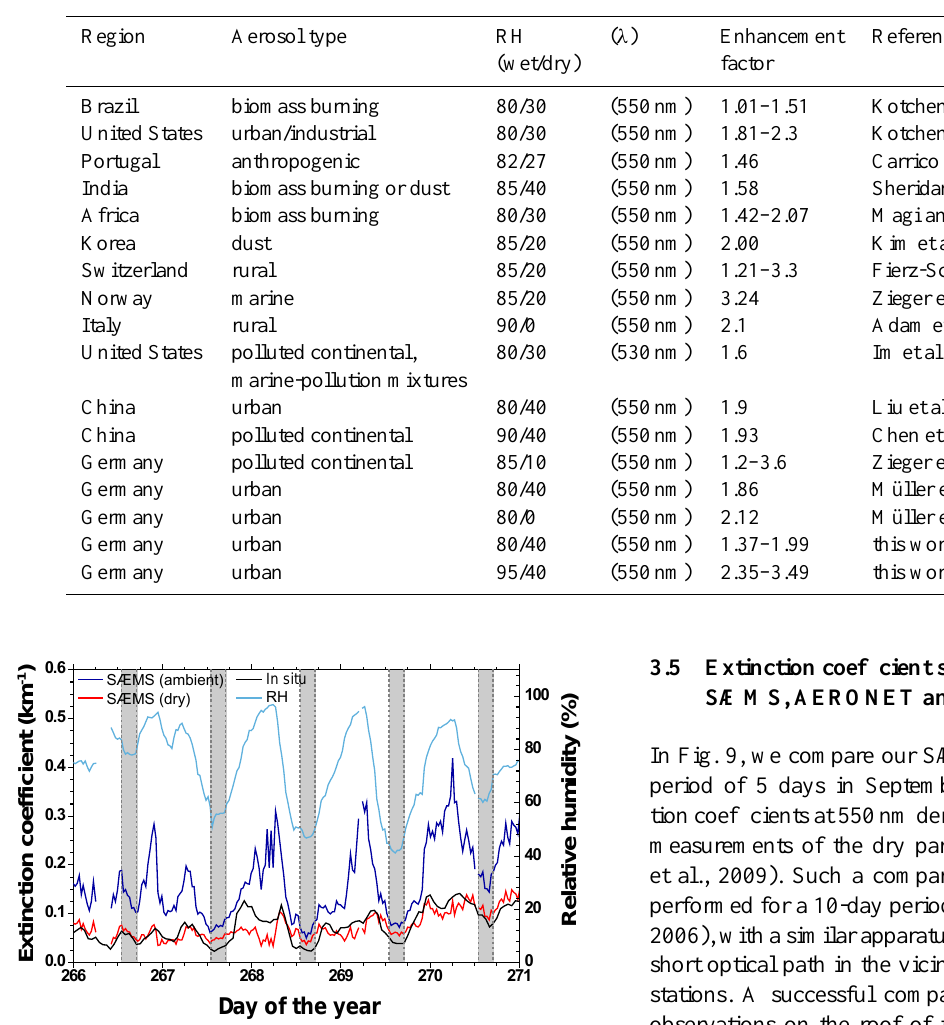
Table 1. Overview of published particle extinction enhancement factors based on extinction values measured at different values of relative humidity RH (%).